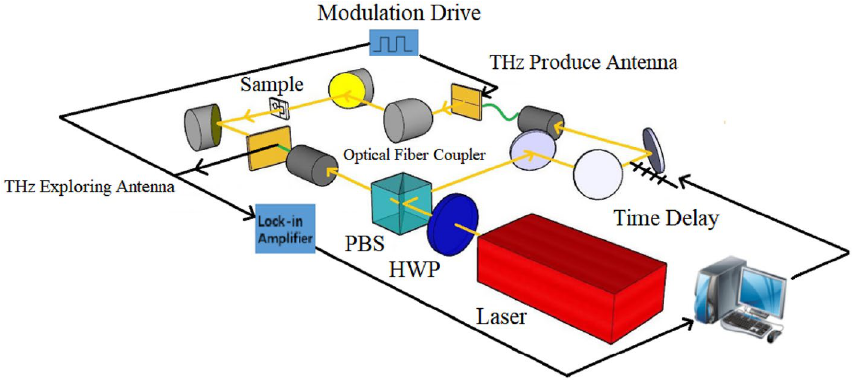
Figure 1. THz time domain spectroscopy